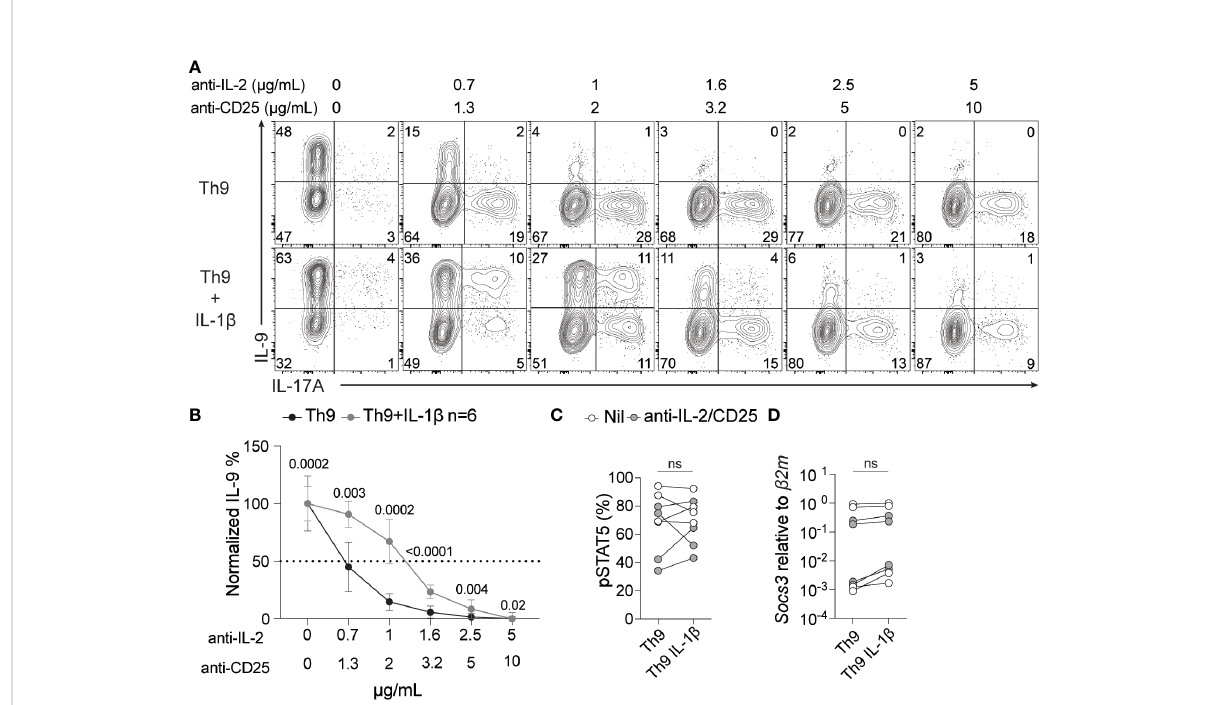
FIGURE 5 IL-1 b signaling enhances IL-2 sensitivity during Th9 differentiation. Th9 cells were cultured in the presence or absence of IL-1 b and increasing amounts of anti-IL-2/CD25 and IL-9 and IL-17A were measured by ICS at day 5 of culture. (A) Representative contour plots of intracellular IL-9 and IL-17A after restimulation with PMA and ionomycin. (B) Quanti fi cation of %IL-9 + Th cells at day 5 of culture from panel A, p<0.05 by paired Student ’ s t-test was considered signi fi cant, error bars represent SD. pSTAT5 protein (C) and Socs3 mRNA (D) levels of Th9 cells with or without IL-1 b at no IL-2/CD25 blockade (Nil) or at 1 m g/ml anti-IL-2/2 m g/ml anti-CD25 (anti-IL-2/CD25). Data in panel A and B are representative of naïve T cell cultures from 6 mice and pSTAT5 and Socs3 data are representative of cultures from 4-6 mice from 2 pooled experiments. ns, non-signi fi